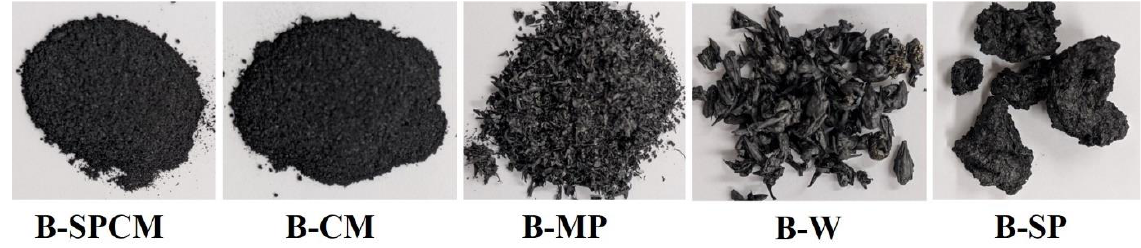
Figure 3. The photo of different textures of the biochar products formed. The percentage yield was calculated using the formula below.